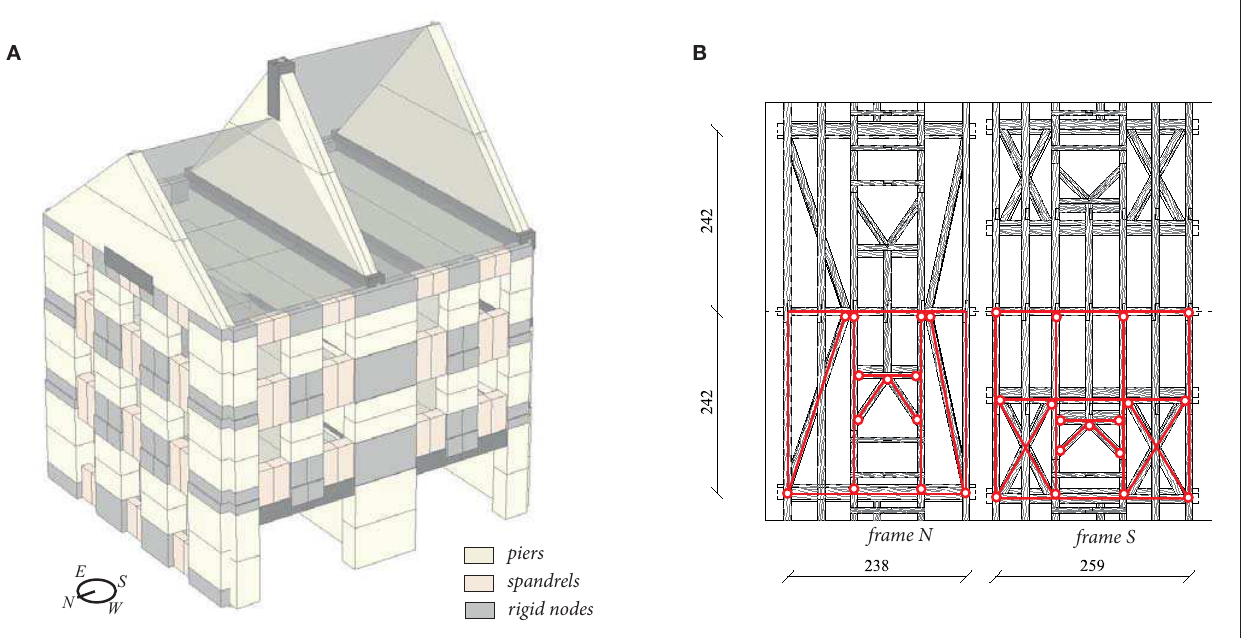
FIGURE 2 | Stone masonry building: (A) equivalent frame model of the complete building and (B) estimate of the roof diaphragm stiffness through an equivalent system of trusses.